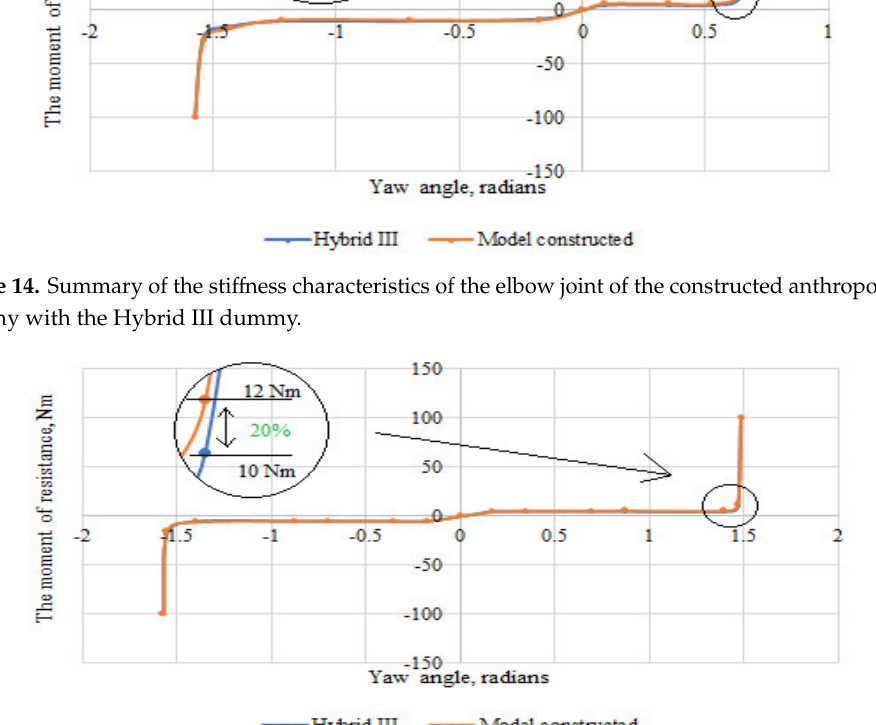
Figure 15. Summary of the sti ff ness characteristics of the wrist joint of the constructed anthropometric